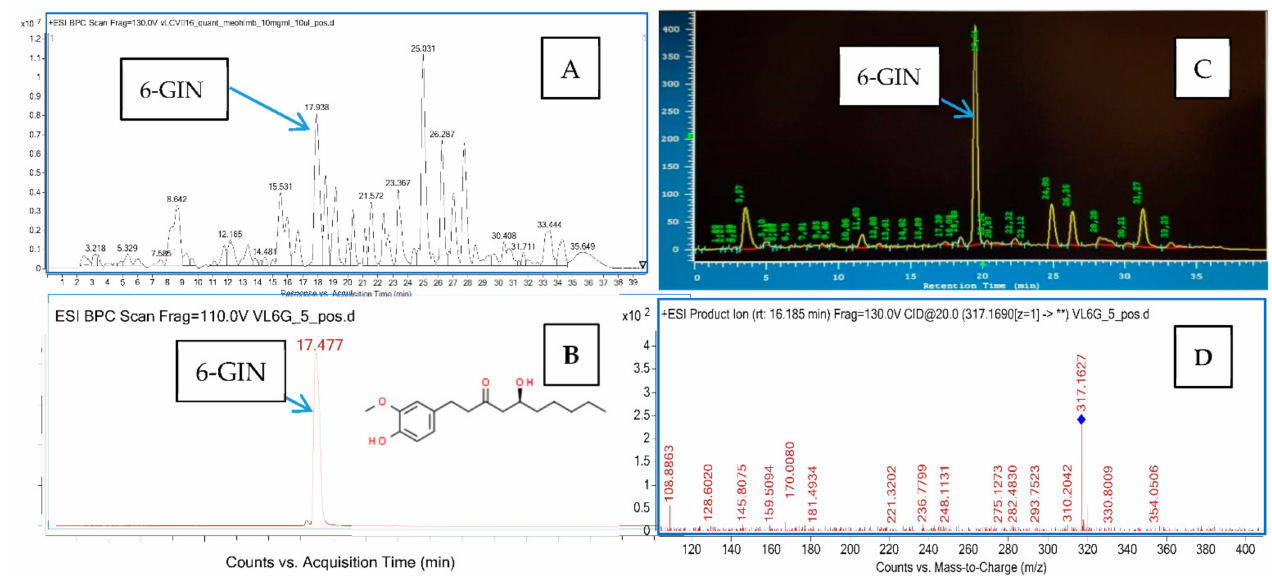
Figure 2. The chromatograms and fragmentation spectra obtained for the total extract and the isolated 6-GIN. ( A ) the total ion chromatogram of the methanolic extract from Zingiber officinale rhizome recorded in the positive ionization mode; ( B ) the total ion chromatogram of the isolated 6-GIN recorded in the positive ionization mode; ( C ) the chromatogram from the semipreparative HPLC, recorded at 290 nm; and ( D ) the MS/MS fragmentation spectrum of